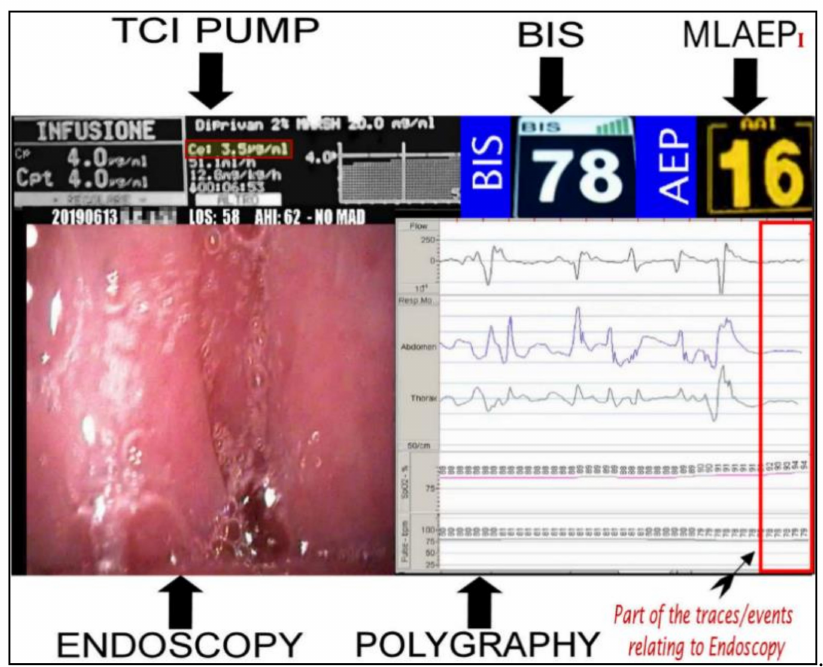
Figure 4. Bispectral index (BIS) and Middle latency auditory evoked potential index (MLAEPi) sedation levels from a 5VsEs (5 Video stream Experimental system) monitor. The MLAEPi value shows a real time correlation with the effect site propofol concentration (3.5 µ g/mL), endoscopic pattern and the polygraphic findings of (Central Sleep Apnoea)